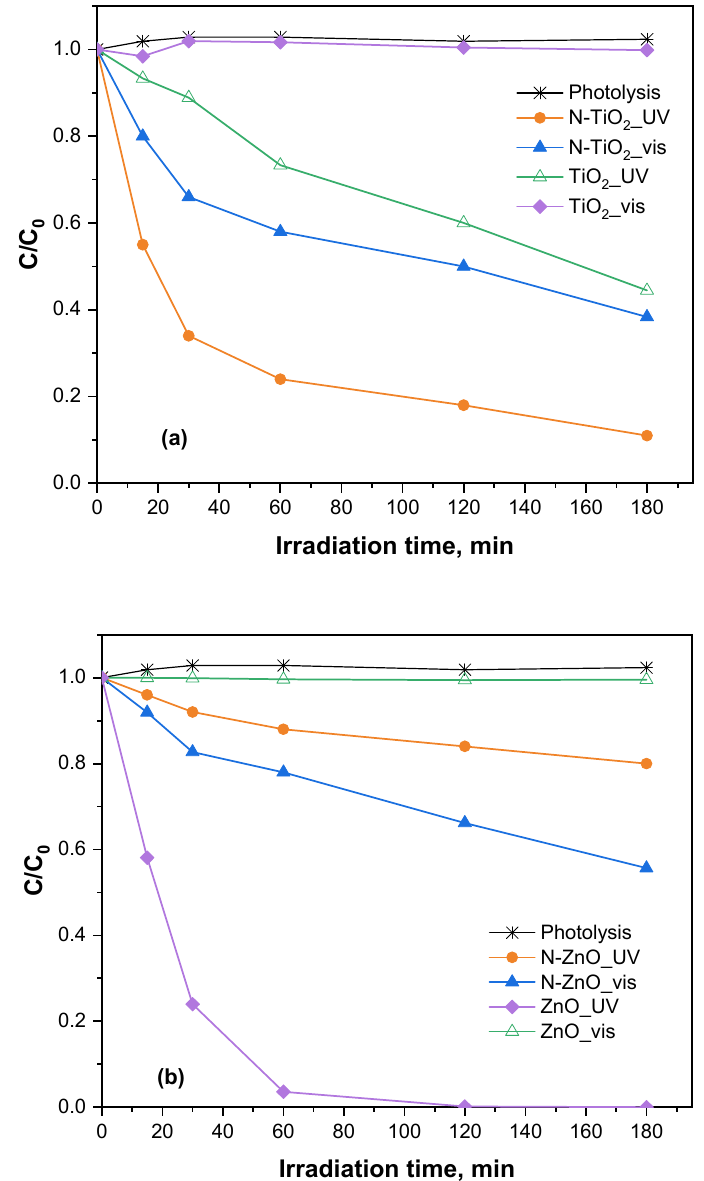
Figure 6. Photocatalytic activity under UV and visible light for ( a ) TiO 2 and N-TiO 2 , as well as ( b ) ZnO and N-ZnO samples.